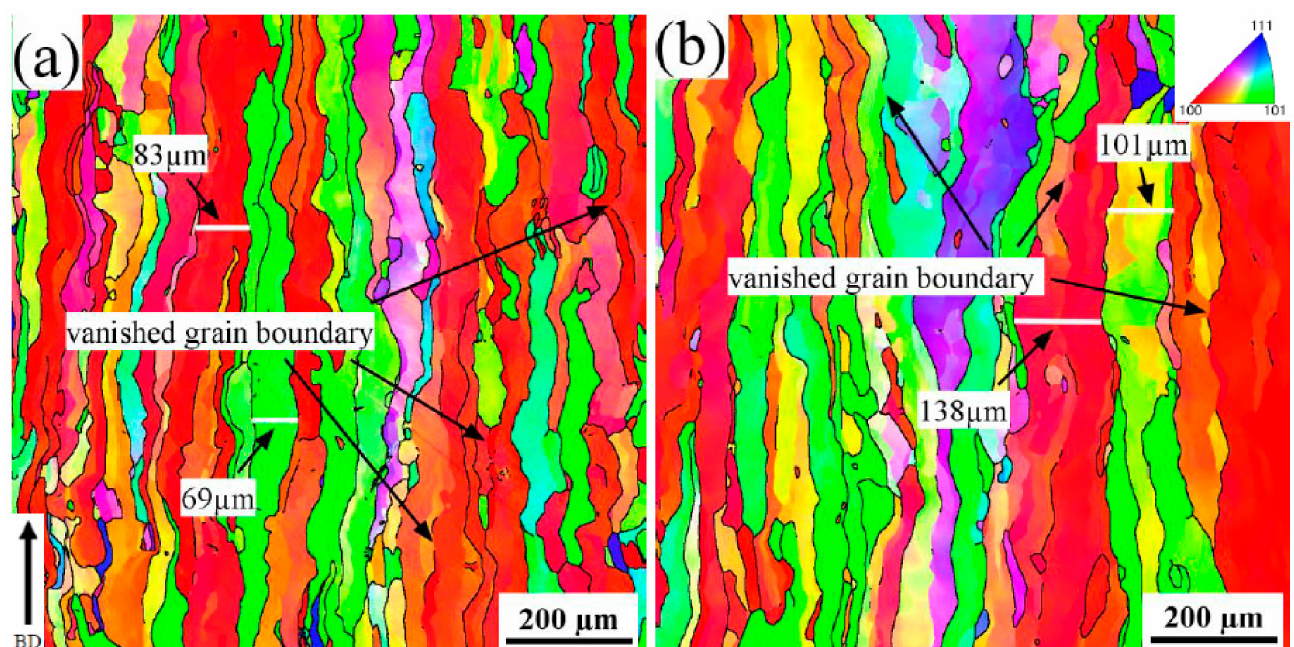
Figure 11. The EBSD results along the building direction of SLMed Ta after heat treatments with different temperature: ( a ) 1200 ◦ C and ( b ) 1600 ◦ C.